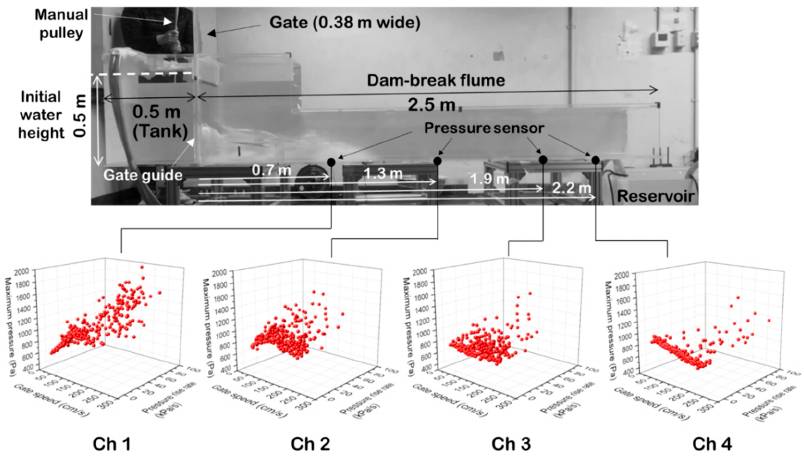
Figure 1. Side view of the experimental dam-break flume, immediately after the gate manually lifted. Bottom pressures were measured with four sensors (Ch1–Ch4). The data on gate speed, maximum pressure, and pressure rise rate are compared in order to investigate the statistical relationship.